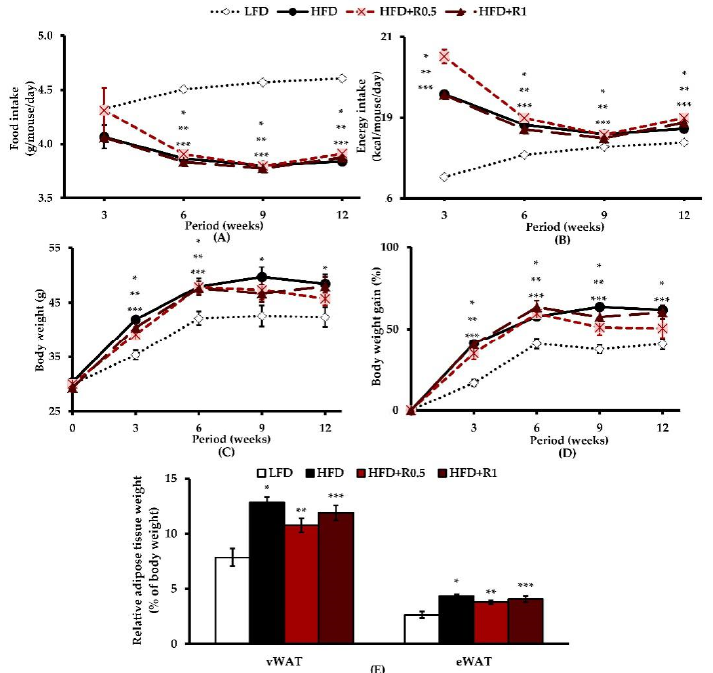
Figure 1. Effects of RRBE on characteristics of HFD ‐ induced obese mice: ( A ) food intake–time curve; ( B ) energy intake–time curve; ( C ) body weight–time curve; ( D ) body weight gain–time curve; ( E ) relative adipose tissue weight. Data are presented as means ± SEM of 8 mice per group and were analyzed by one ‐ way ANOVA followed by Tukey’s post hoc test. *, **, *** p < 0.05 for HFD, HFD + R0.5, and HFD + R1 groups versus LFD group, respectively.